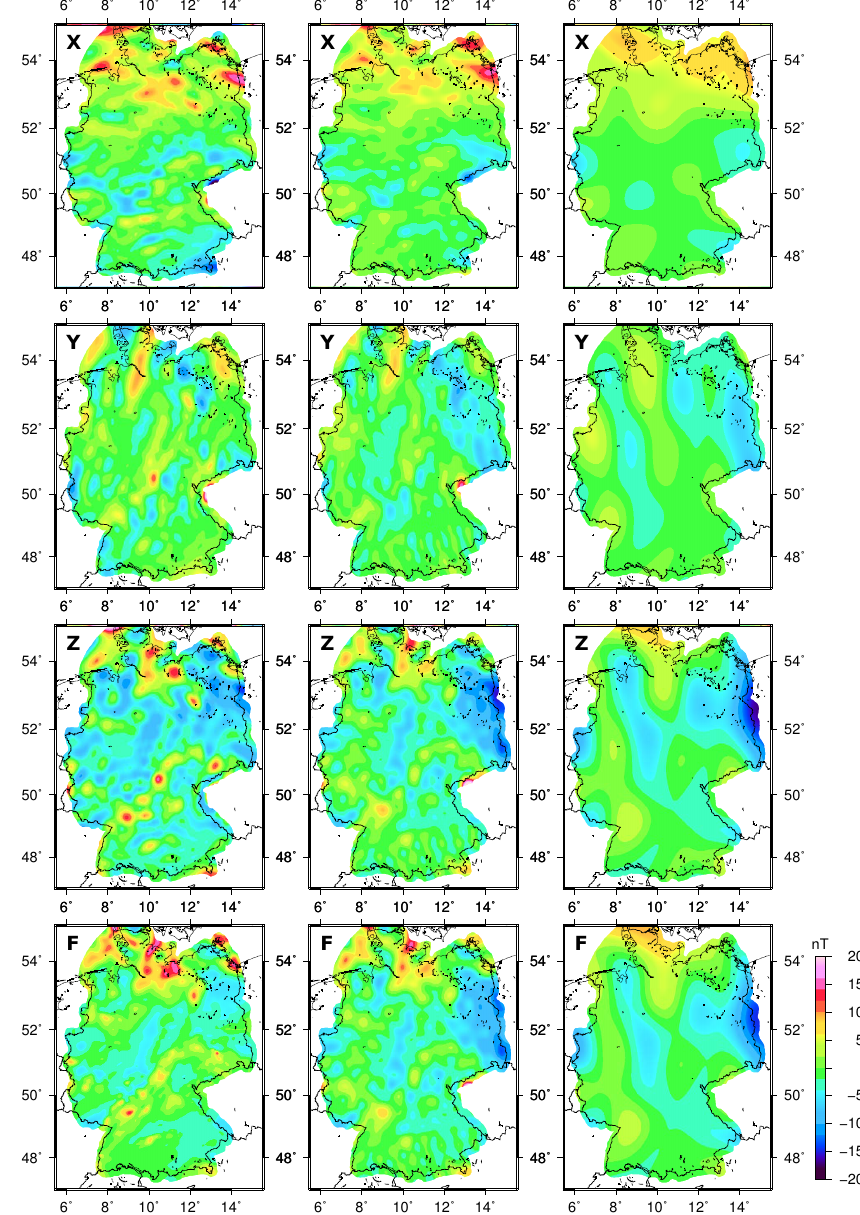
Figure 5. Different lithospheric field maps for Germany: regional R-SCHA model (orthogonal components) by Korte and Thébault (2007) and scalar grid by Gabriel et al. (2011) (left), global EMM2010 model of full (SH degrees 15–720) resolution (middle) and truncated (SH degrees 15–200) EMM2010 (right). North ( X ), east ( Y ), vertical ( Z ) anomaly components and scalar total field ( F ) anomaly from top to bottom. All maps are on the same colour